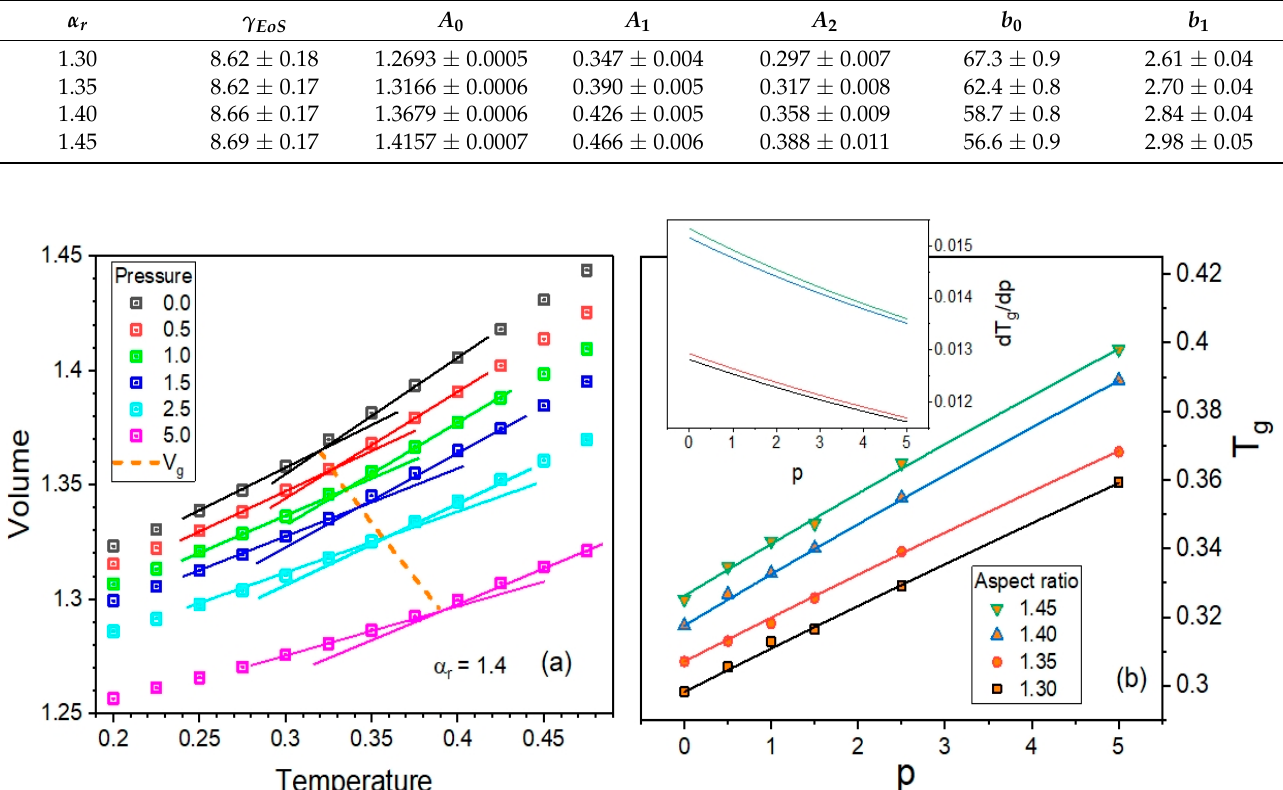
Figure 2. ( a ) Presentation of the method for determining the glass transition curve based on the pVT data for an aspect ratio equal to 1.40. ( b ) Plot of the dependences of the glass transition temperature T g on pressure p for the examined anisotropy aspect ratios α r . The solid curves represent fits to the Andersson–Andersson equation [37], and their derivatives calculated numerically are shown in inset.